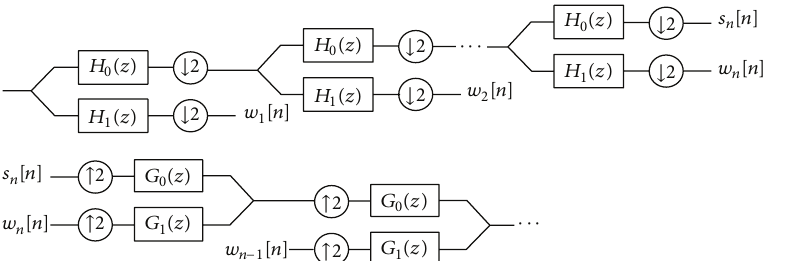
Figure 2: The analysis and synthesis parts of the tree structured discrete wavelet transform. The decomposition consists of the wavelet sequences 𝑤 𝑖 [𝑛], 𝑖 = 1, 2, .. ., 𝑛 and one scaling sequence 𝑠 𝑛 [𝑛]